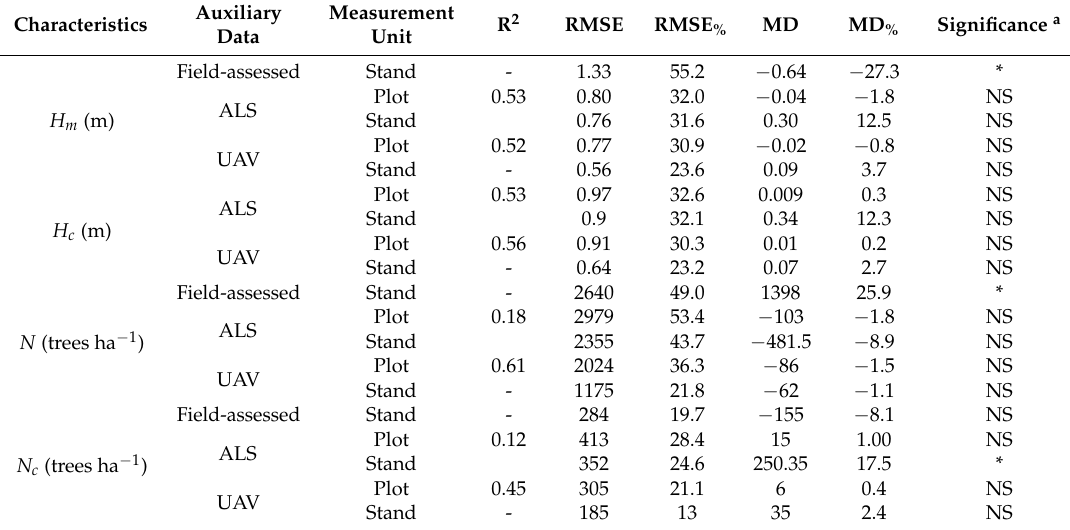
Table 5. Summary of the accuracy in terms of root mean square error, ( RMSE ) its value as percentage of the mean ( RMSE % ), the mean difference ( MD ) and its value as percentage of the mean ( MD % ) for the studied forest biophysical variables and auxiliary